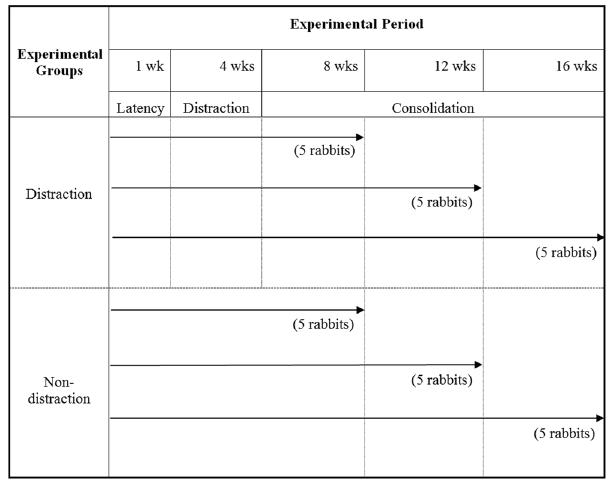
Figure 5. Experimental time table. After 7 days of latency following surgery, distraction was conducted at the rate of 0.7 ml/7 days × 3 times (total of 2.1 ml over 21 days). Ten rabbits (5 in the distraction group and 5 in the non-distraction group) were euthanized at postoperative 8, 12, and 16 weeks. Distraction and non-distraction subgroups were assigned according to the consolidation